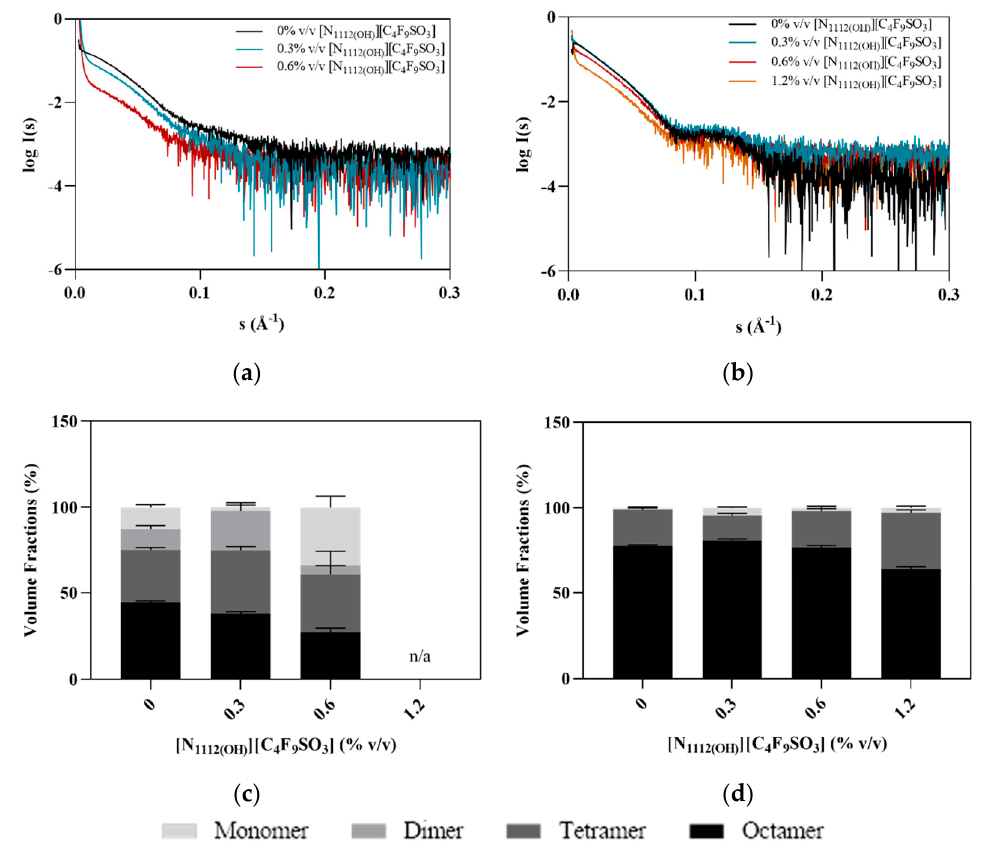
Figure 7. Effect of [N 1112(OH) ][C 4 F 9 SO 3 ] on the SAXS profile of hPAH. ( a ) Experimental scattering curves of hPAH + FIL; ( b ) experimental scattering curves of hPAH + L-Phe + FIL; ( c ) volume fractions of oligomers in hPAH + FIL samples; ( d ) volume fractions of oligomers in hPAH + L-Phe + FIL samples.